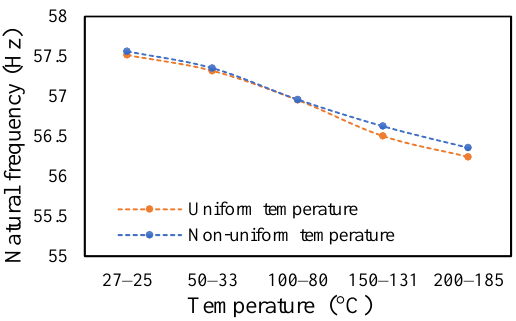
Figure 19. Comparison of natural frequency of undamage specimen ramped at 2 °C/min.